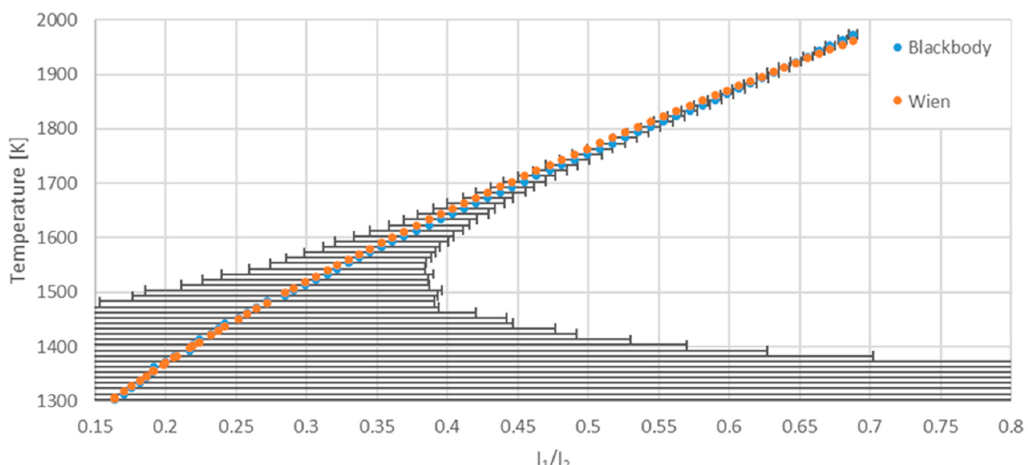
Figure 2. This figure shows the temperature calibration data from blackbody reference measurements and the fitted function data of Wien’s law Equation (1). and the fitted function data of Wien’s law Equation (1).